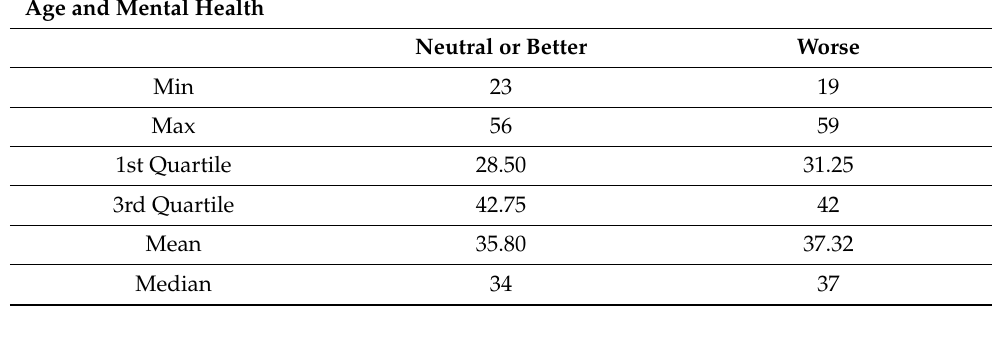
Table 5. Descriptive Statistics of the age between the answers in mental health.